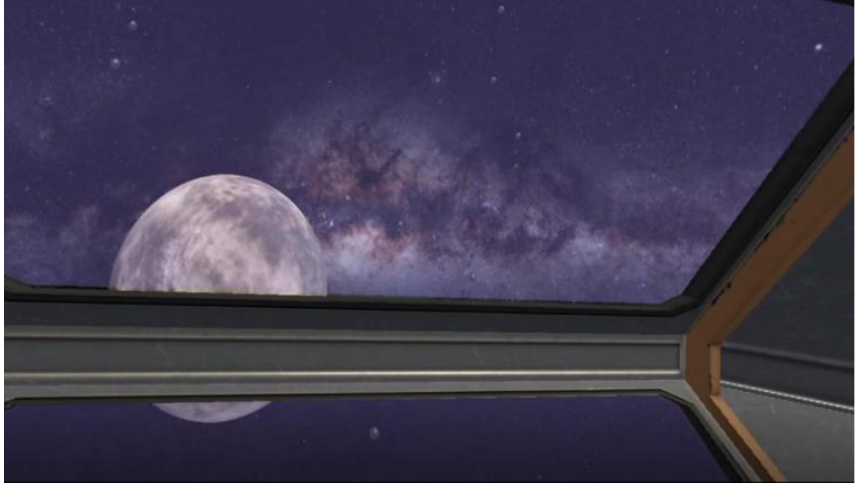
Figure 10. Deformation of planet as the spacecraft increasing its speed. Before the spacecraft reaches Proxima Centauri, an alien spaceship will appear on the way to the destination. If the learner can correctly calculate the speed of the alien spaceship, they can avoid the enemy’s attack. If the calculation is incorrect, the spacecraft will be attacked by the enemy (Figure 11). For example, if the learner drives the spacecraft at 0.9 times the speed of light and the alien spaceship suddenly approaches at the same speed, relative to the Earth coordinate system, the challenge question is: “What is the speed of the alien spaceship measured by the human pilot?” According to the Lorentz transformation, the human pilot will measure the alien spaceship moving forward at the speed u (cid:48)